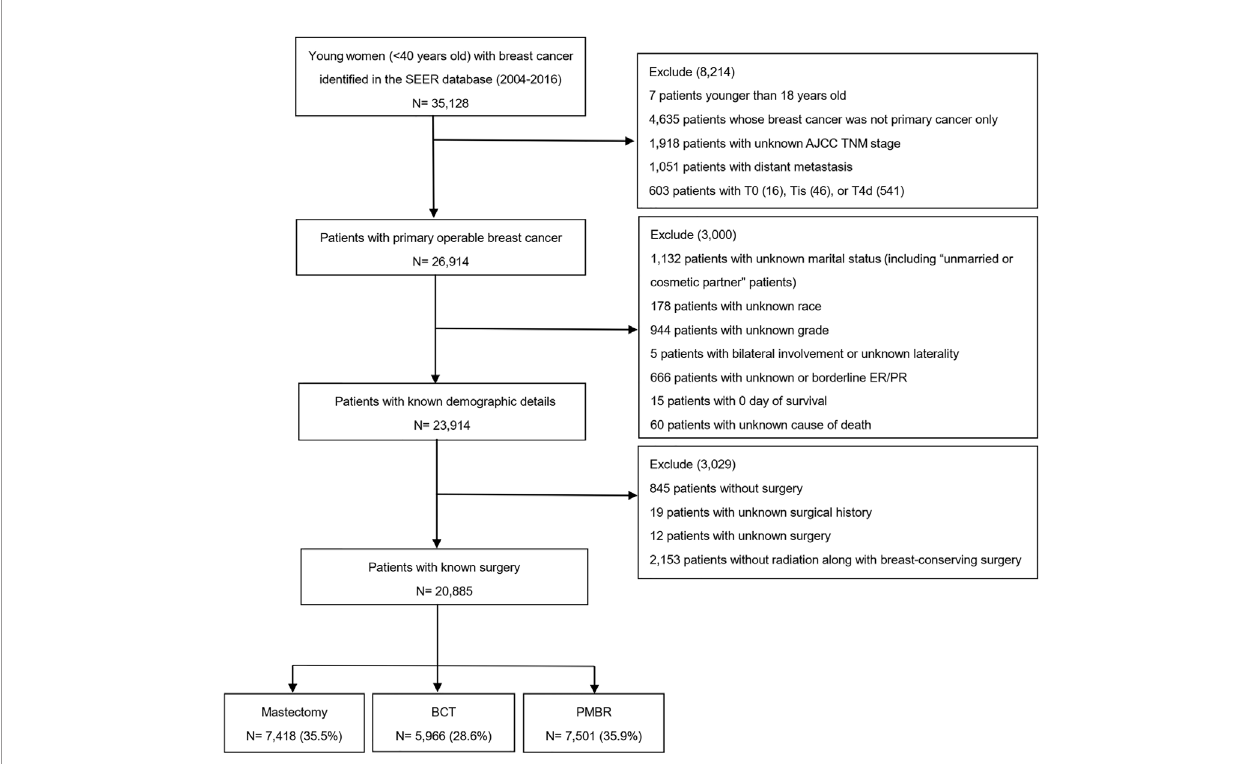
FIGURE 1 | Flow diagram for creation of the study cohort. SEER, Surveillance, Epidemiology, and End Results; AJCC, American Joint Committee on Cancer; BCT, breast-conserving therapy; PMBR, post-mastectomy breast